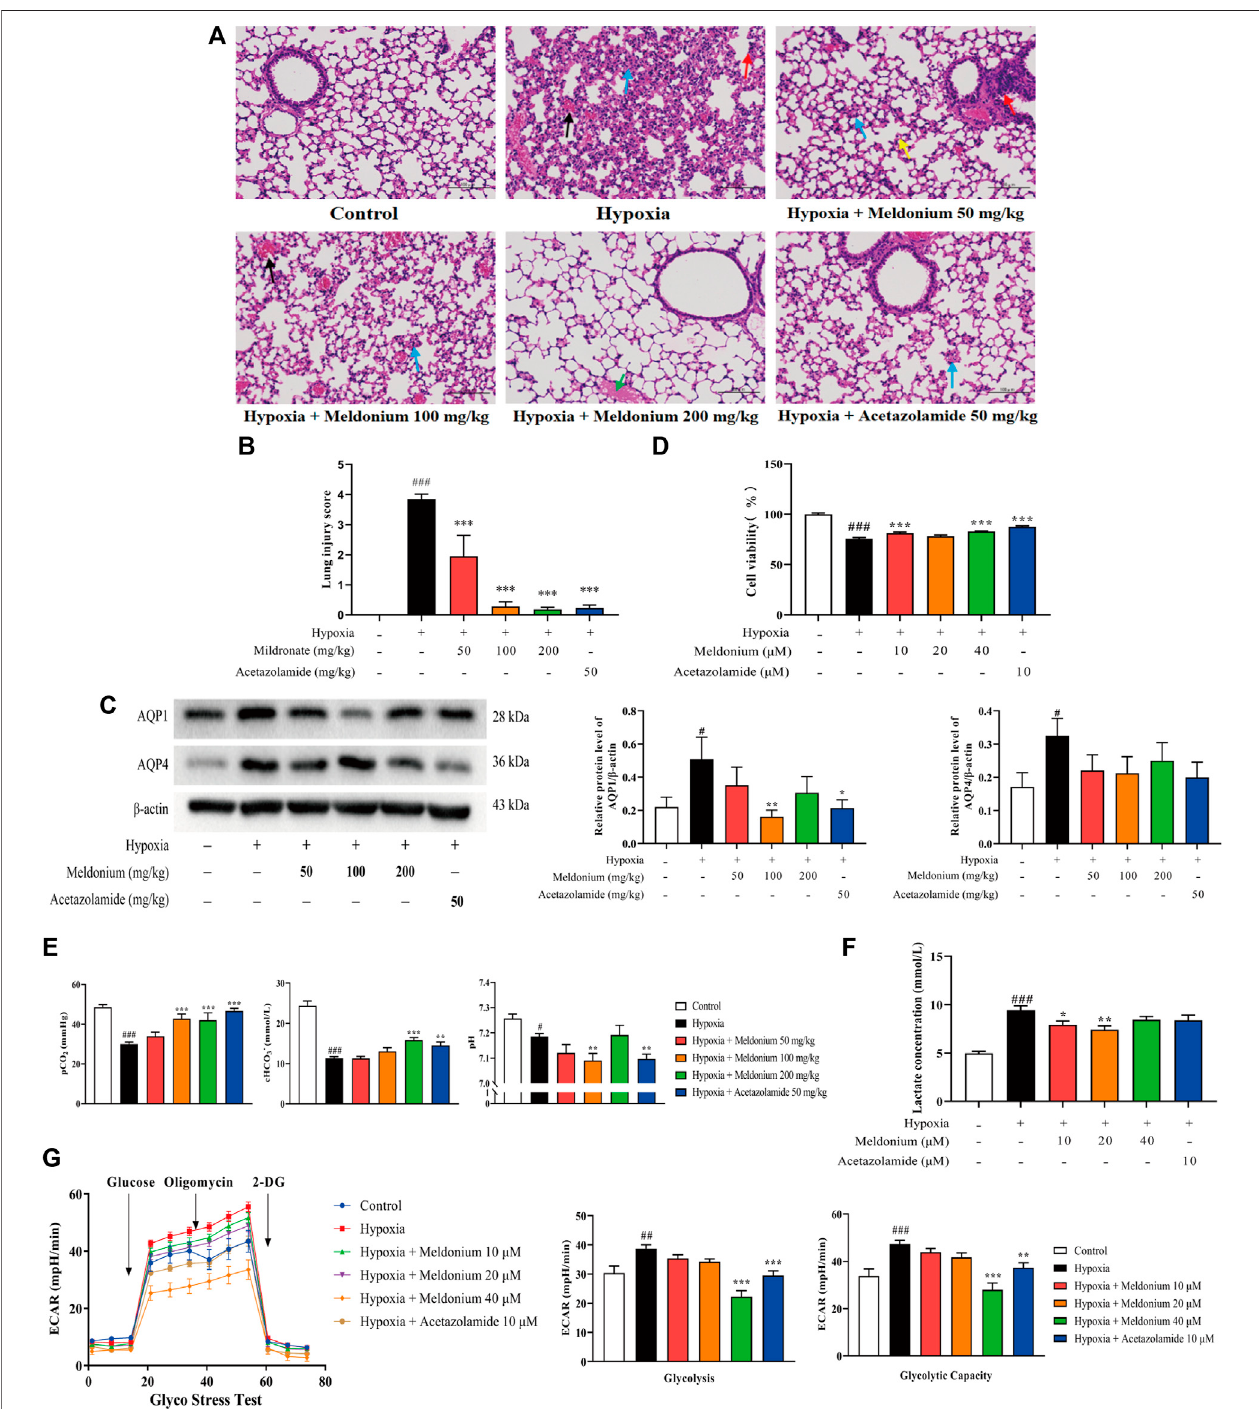
FIGURE 1 | Meldonium treatment attenuated hypoxia-induced lung injury and regulated hypoxia-enhanced glycolysis. (A) Histopathology of mouse lungs stained with haematoxylin and eosin (200×, n = 7). Black arrowheads indicate haemorrhage, blue arrowheads indicate alveolar wall thickening and alveolar epithelial cell hyperplasia, red arrowheads indicate in fl ammatory cell in fi ltration, yellow arrowheads indicate alveolar atrophy, and green arrowheads indicate protein mucus. (B) Lung injury score in vivo ( n = 7). (C) AQP1 and AQP4 protein expression in lung tissues of lung injury mice ( n = 7 – 8). (D) Cell viability in vitro ( n = 6). (E) Blood gas parametersin mice after hypoxia for 24 h ( n = 5 – 11). (F) Lactate concentration in thesupernatant ofcell culture medium in vitro (n =5). (G) Extra cellular acidi fi cation rate (ECAR) diagram; glycolysis and glycolytic capacity were detected using the Glyco Stress Test Kit in vitro ( n = 5 – 6). Data are expressed as the mean ± standard error of mean(SEM).Statisticalanalyseswereperformedusingone-wayanalysisofvariance(ANOVA)followedbyFisher ’ sleastsigni fi cantdifference(LSD)test.# p < 0.05,## p < 0.01, ### p < 0.001 compared with the control group; * p < 0.05, ** p < 0.01, *** p < 0.001 compared with the hypoxia group.